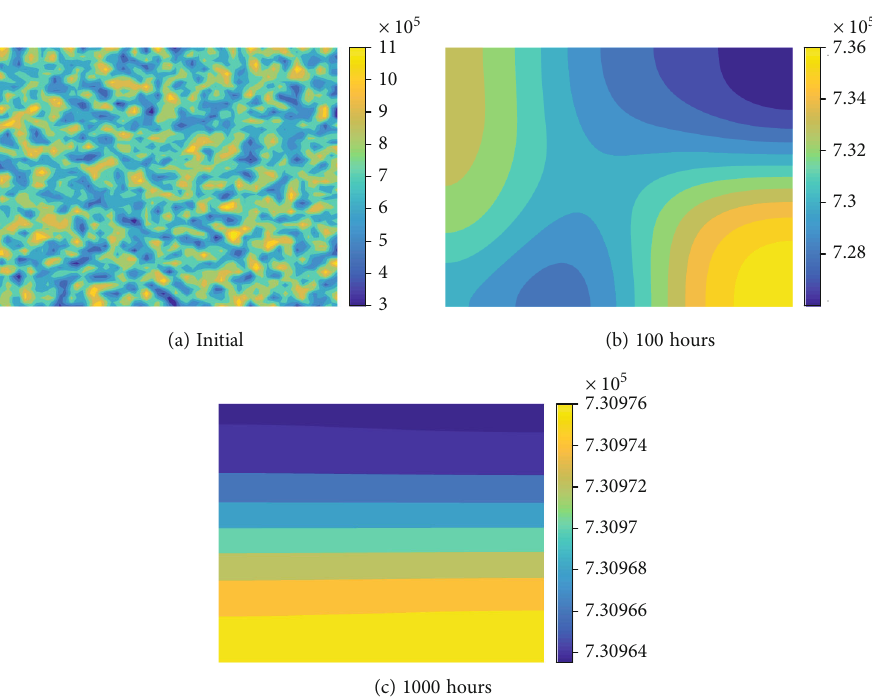
Figure 4: Pressure distributions computed by the classical model in example 1 at di ff erent times.